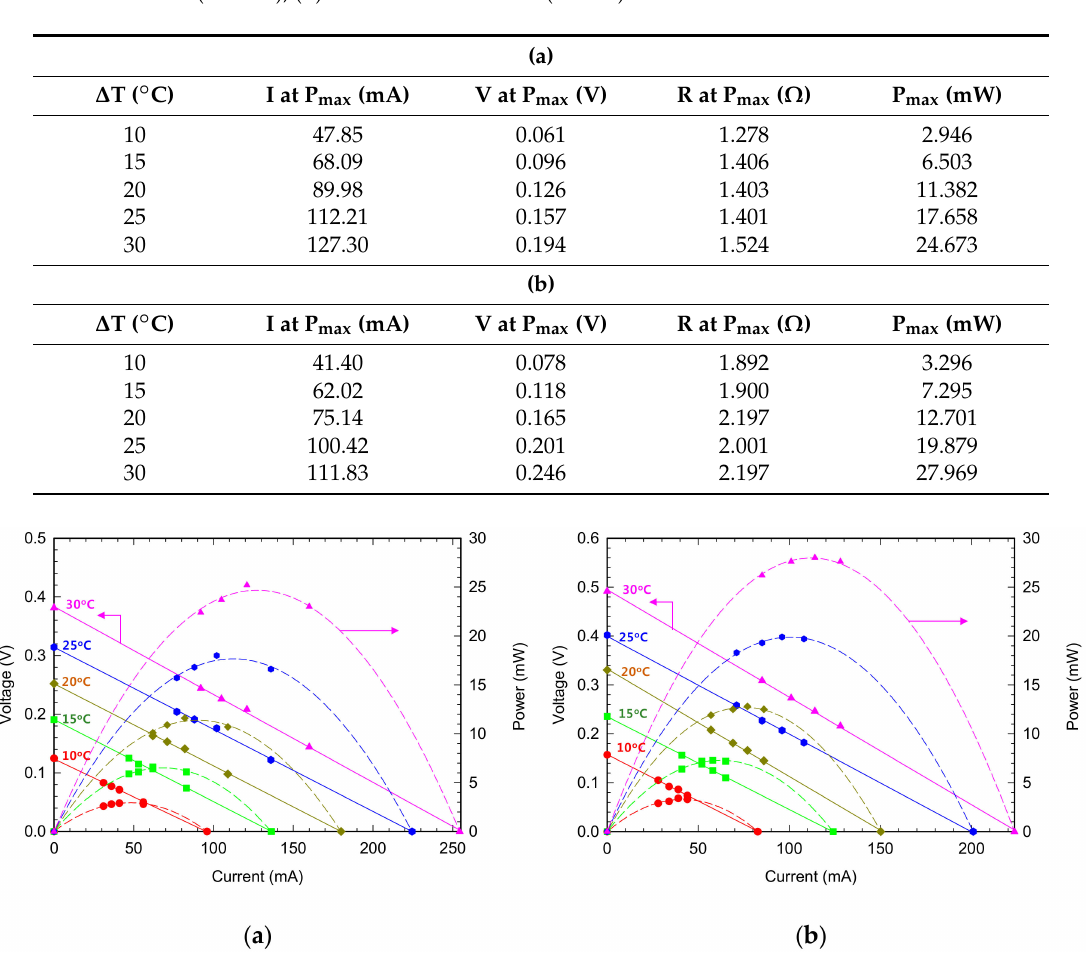
Table 2. Results of output performance test on TEMs with varying external load resistance, ( a ) results